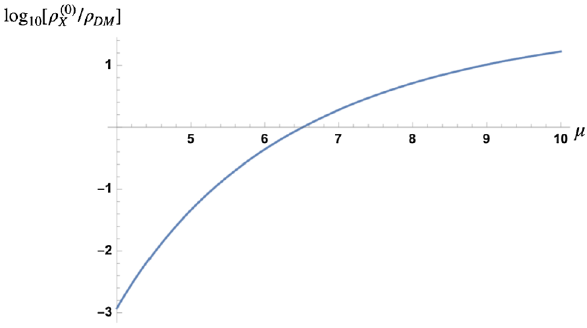
Fig. 6 Logoftheratiooftheenergydensityof X -particles(4.15)tothe observed energy density of dark matter as a function of μ = M R / M